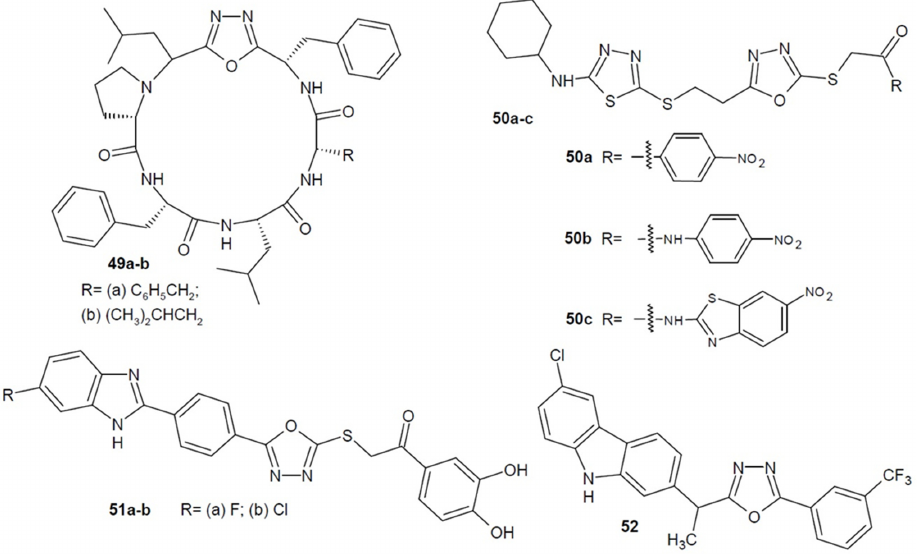
Figure 18. 1,3,4-oxadiazole derivatives with antifungal activity (part